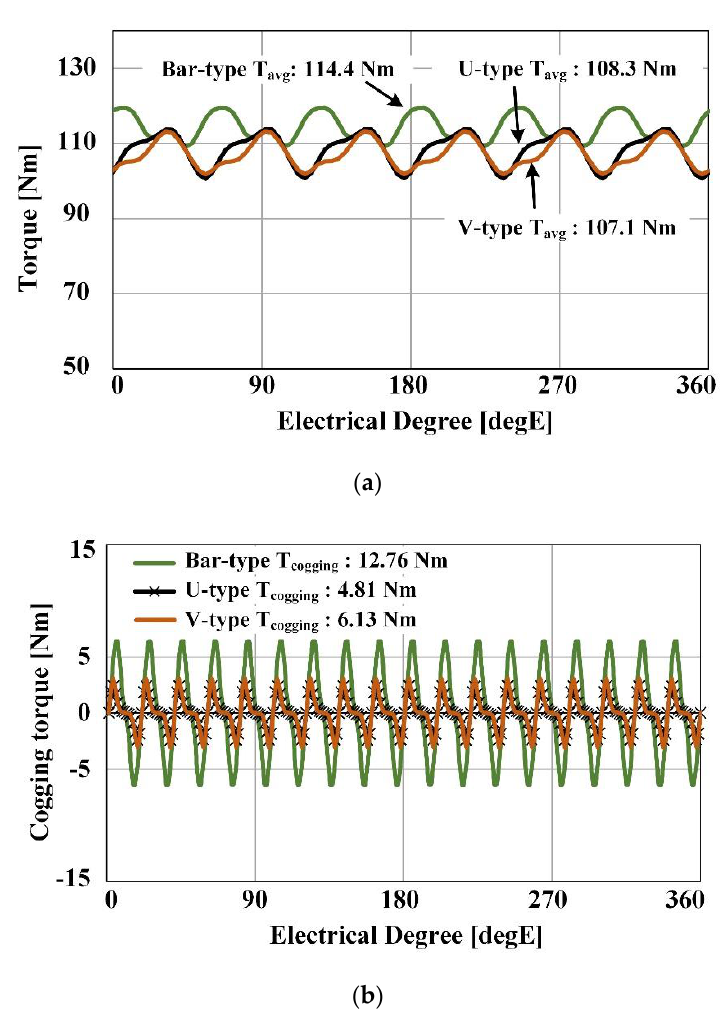
Figure 3. Wave form of three types of motors. ( a ) Torque; ( b ) cogging torque.